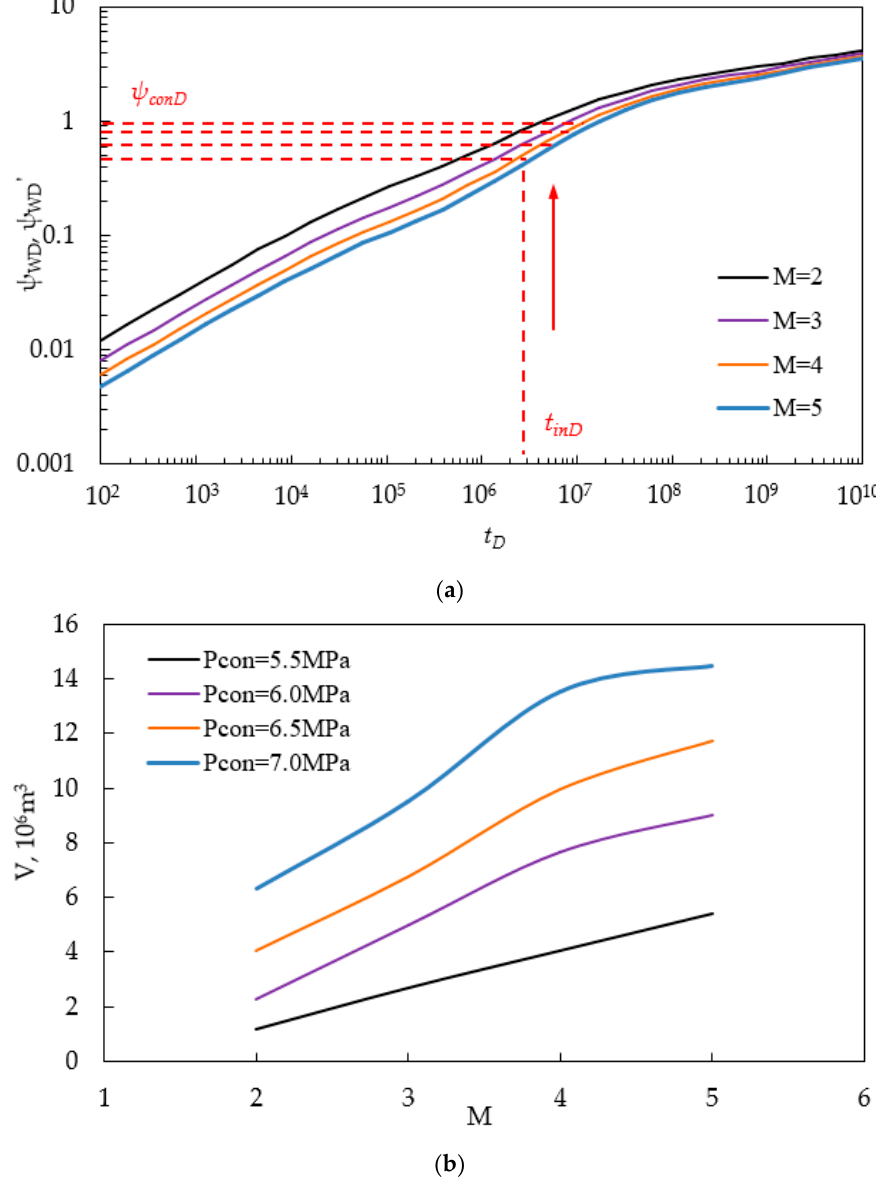
Figure 16. ( a ) Comparison pressure with different fracture number; ( b ) comparison of CO 2 storage capacity with different fracture number.